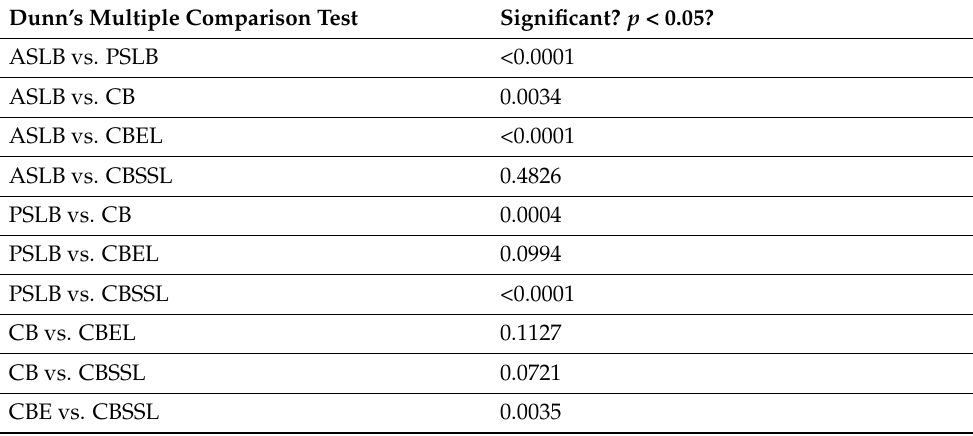
Table 3. Dunn’s post hoc test—tensile